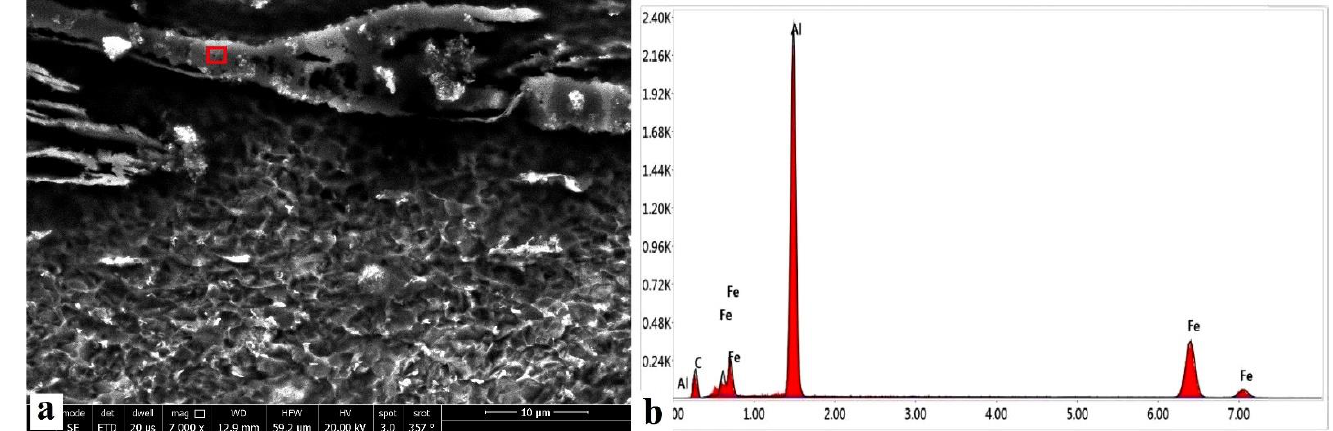
Figure 6. EDS analysis of one of the layers located at the aluminum/steel interface produced with high FSP rotation speed of 1500 rpm and pin length of 3 m: ( a ) SEM image of one of the lamanater layers and ( b ) EDS analysis of the red box in ( a ).